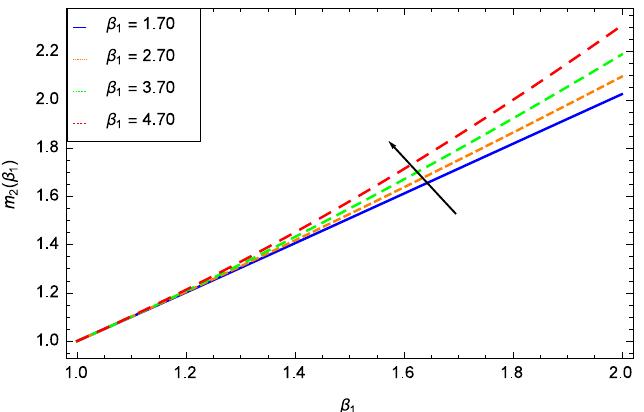
Figure 17. Rate of spray m 2 ( β 1 ) sketch for h = 0.10, M = 0.10, Re = 0.70, φ = 0.04, Pr = 6.80 and various values of β 1 (CuO-H 2